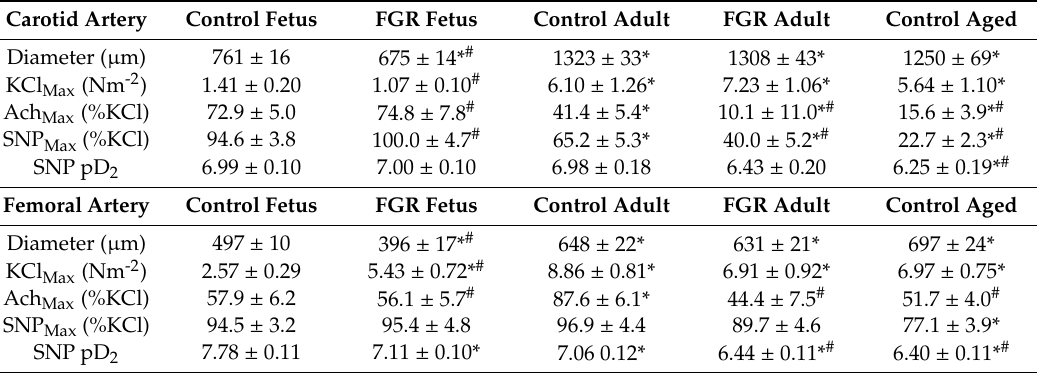
Table 2. Ex vivo vascular responses in carotid and femoral